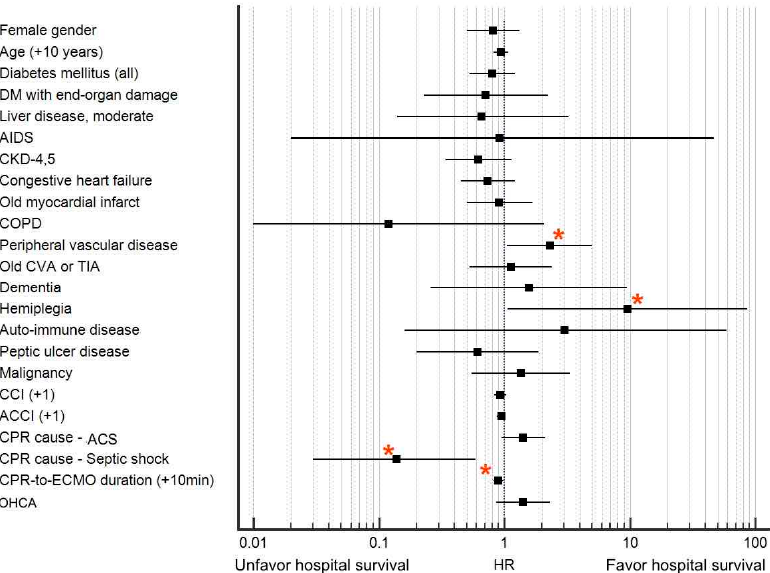
Figure 3. Hazard ratio (HR) of individual factors for hospital survival. Four significant risk factors are marked with red asterisks, namely peripheral vascular disease (HR = 2.3, 95% confidence interval (CI) = 1.05–5.02, p = 0.037), hemiplegia (HR = 9.6, 95% CI = 1.06–86.8, p = 0.04), cardiopulmonary resuscitation (CPR) due to septic shock (HR = 0.14, 95% CI = 0.03–0.59, p = 0.007), and CPR duration before extracorporeal membrane oxygenator (ECMO) run (CPR-to-ECMO duration) (HR = 0.9 for +10 min, 95% CI = 0.82–0.99, p = 0.04). Notably, age, Charlson comorbidity index (CCI), and age-adjusted Charlson comorbidity index (ACCI) were not significant risk factors (age: HR = 0.94 for +10 years, 95% CI = 0.82–1.07, p = 0.333; CCI: HR = 0.93, 95% CI = 0.83–1.04, p = 0.205; and ACCI: HR = 0.95, 95% CI = 0.87–1.02, p = 0.164). AIDS: acquired immune deficiency syndrome, CKD: chronic kidney disease, COPD: chronic obstructive pulmonary disease, CVA: cerebral vascular attack, TIA: transient ischemic attack, ACS: acute coronary syndrome, CPR-to-ECMO duration: CPR duration before ECMO run, OHCA: Out-of-hospital cardiac arrest, DM: diabetes mellitus. * Denotes variables with p < 0.05 by univariate